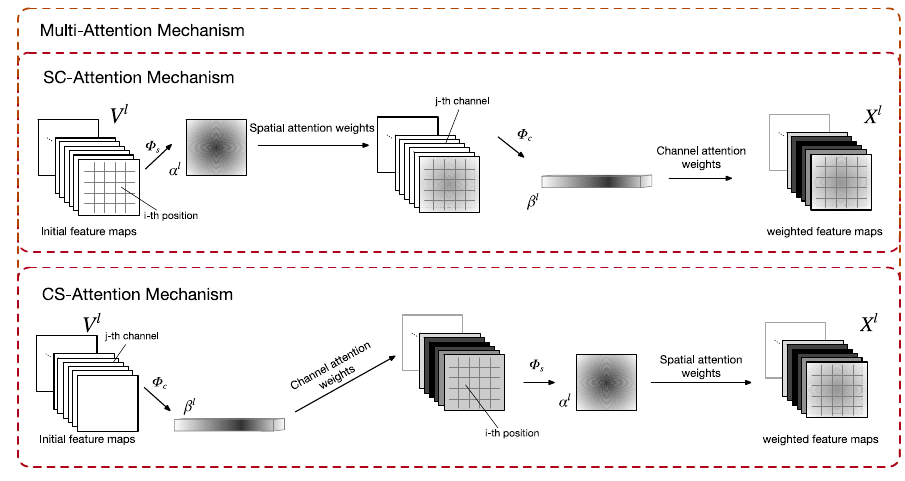
Figure 11. Two types of multi-attention mechanism. Table 3. Recognition accuracy of fault labels I-07 and I-14 using single attention mechanisms.